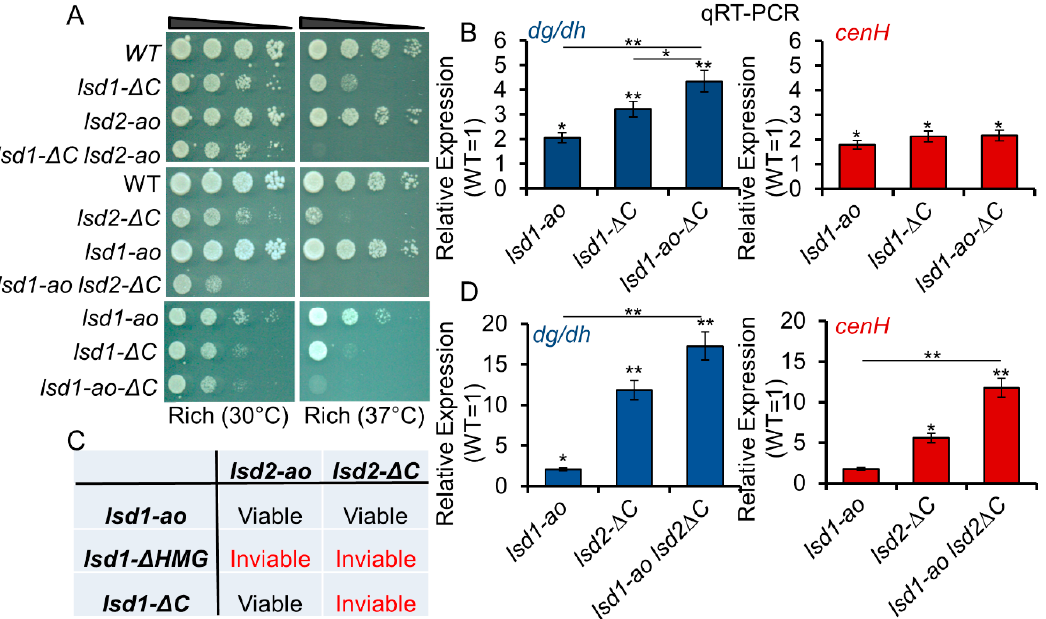
Figure 3 . Lsd1 and Lsd2 serve overlapping, but divergent, functions. ( A ) Serial dilutions demonstrate the synthetic growth defects and heat sensitivities of lsd1 lsd2 double mutants . ( B ) qRT-PCR analysis of peri-centromeric ( dg/dh ) and mating-type ( cenH ) regions show the genetic interactions between lsd1-ao and lsd1- ∆ C and the double mutant allele lsd1-ao- ∆ C. ( C ) Summary of the genetic interactions between lsd1 and lsd2 mutants. ( D ) qRT-PCR analysis of the silenced dg/dh repeats in the peri-centromeric region and cenH (mating-type locus) show the genetic interactions between lsd2- Δ C and lsd1-ao. * p ≤ 0.05 and ** p ≤ 0.01 as determined by student’s t test comparing the indicated samples with WT values. Significance between single mutants and double mutants is indicated by horizontal lines linking the two samples. Error bars represent